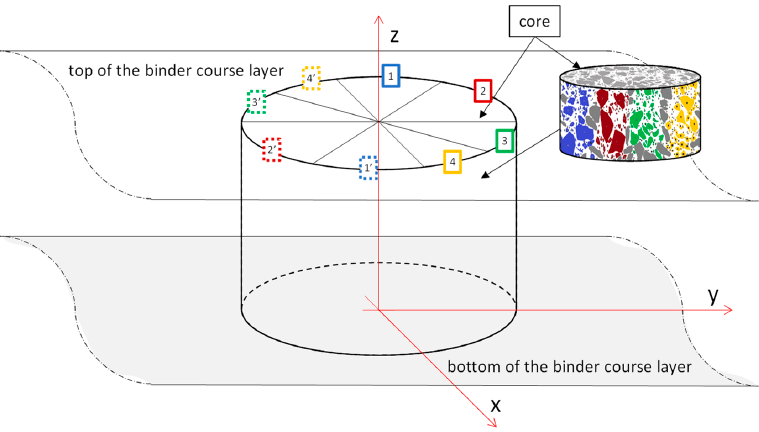
Figure 2. Orientation of the sample according to the axes.